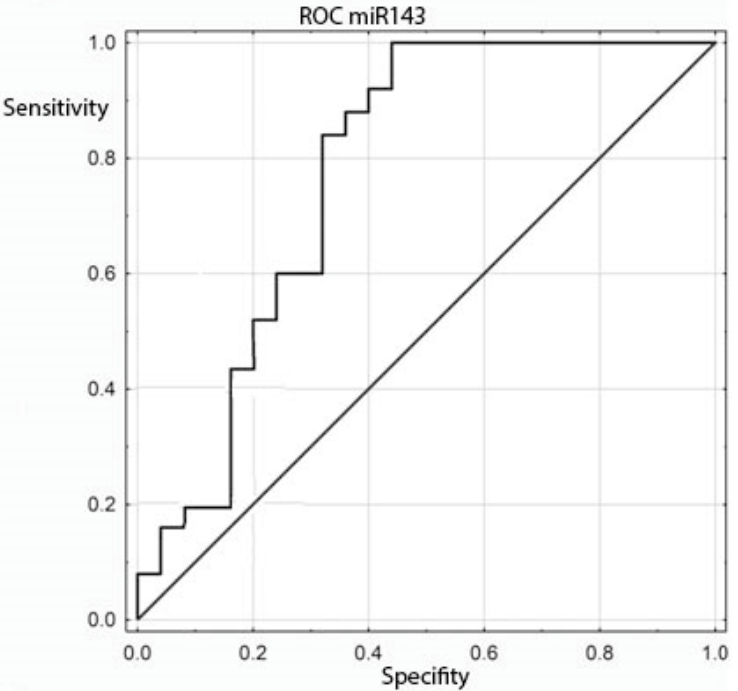
Figure 3. ROC curve for the ability of miR-143 to differentiate between colorectal cancer and positive colorectal cancer lymph nodes.